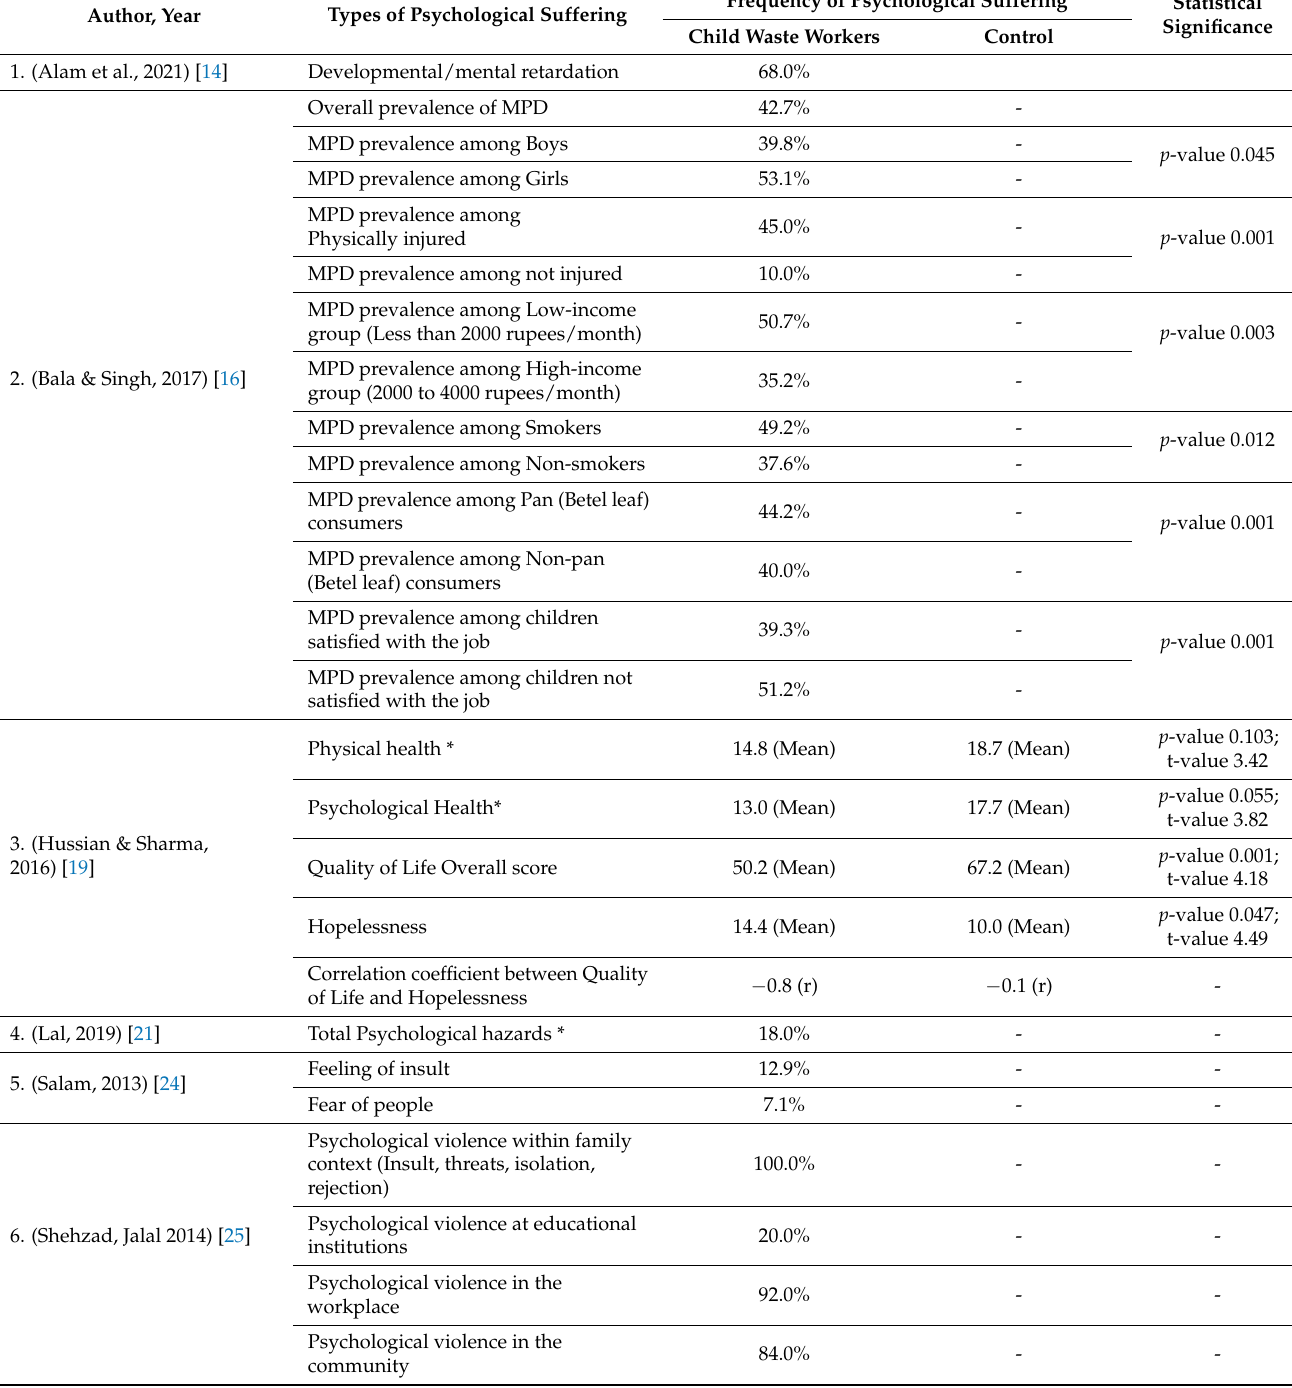
Table 6. Psychological suffering of child waste